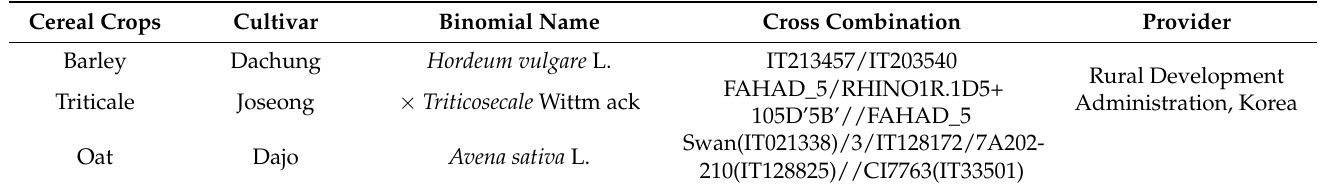
Table 1. Information on cross breeding of barley, triticale and oats used in this experiment. Cereal